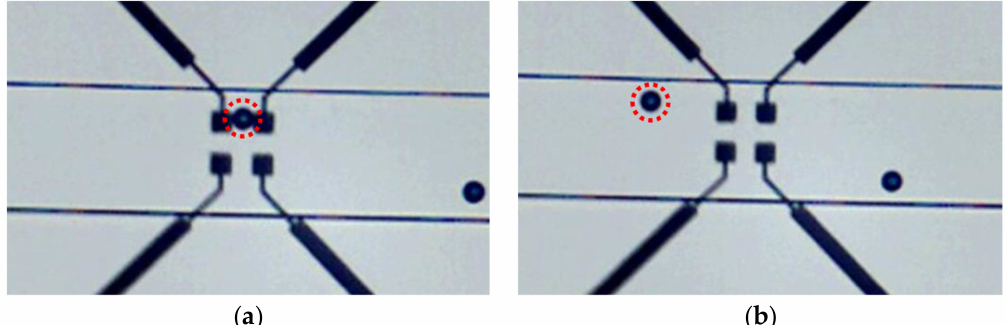
Figure 8. Microscopic image of the biosensor center ( a ) with a microbead between the electrodes for the Z cell measurement and ( b ) without the microbead between the electrodes for the Z ref measurement.